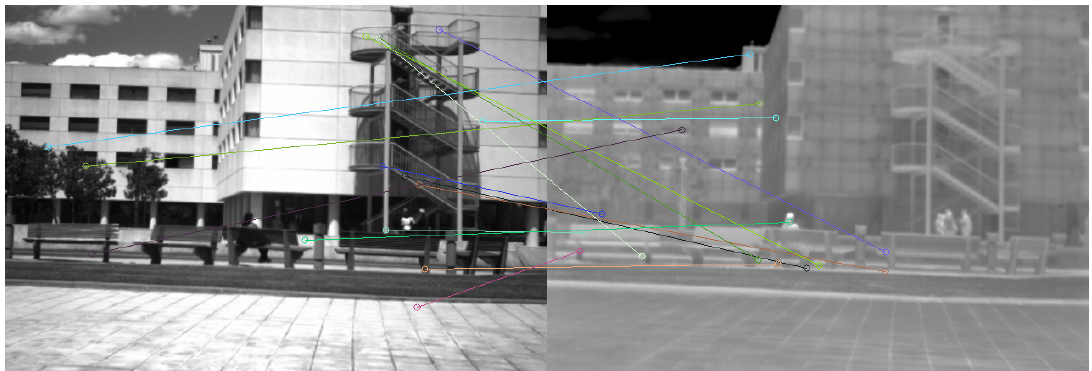
Figure 1. Fundamental matrix calculation made with extracted SIFT features. The numerous faulty matchings pairs do not allow the algorithm to converge to a consistent